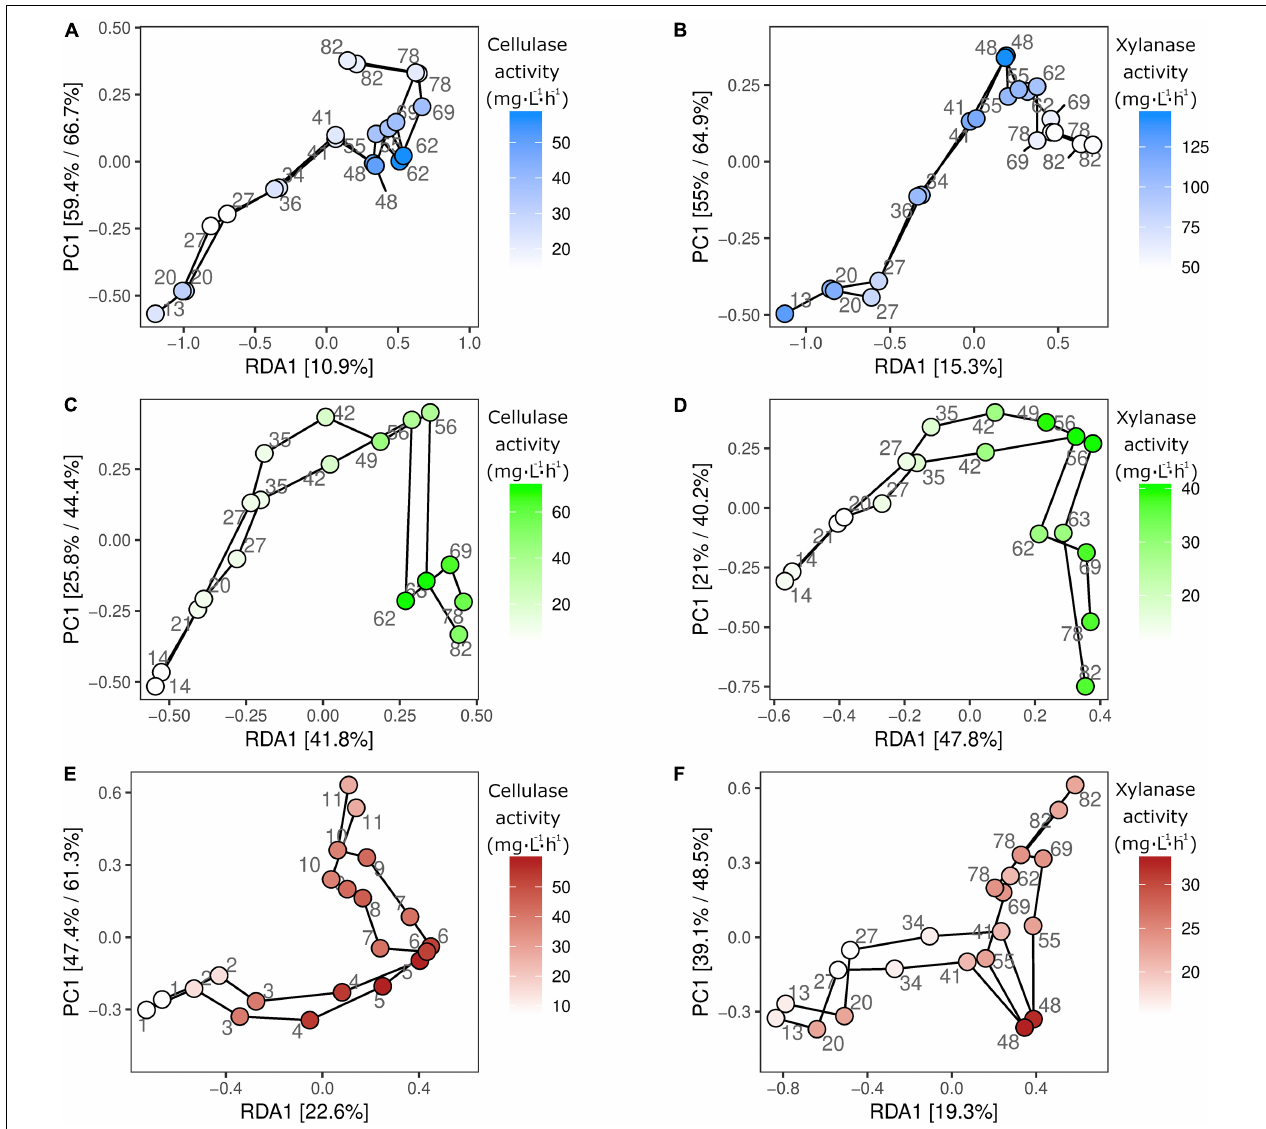
FIGURE 3 | Redundancy analysis. RDA analysis of the sampled duplicate reactors R1 (A,B) , R2 (C,D) , and R3 (E,F) , constrained by either cellulase (A,C,E) or xylanase (B,D,F) activity. Samples are colored by enzymatic activity and a line is drawn between consecutive sampling points in the time series. The individual ASVs are shown on the models as gray dots. R1 is thermophilic, and R2 and R3 are mesophilic reactors.